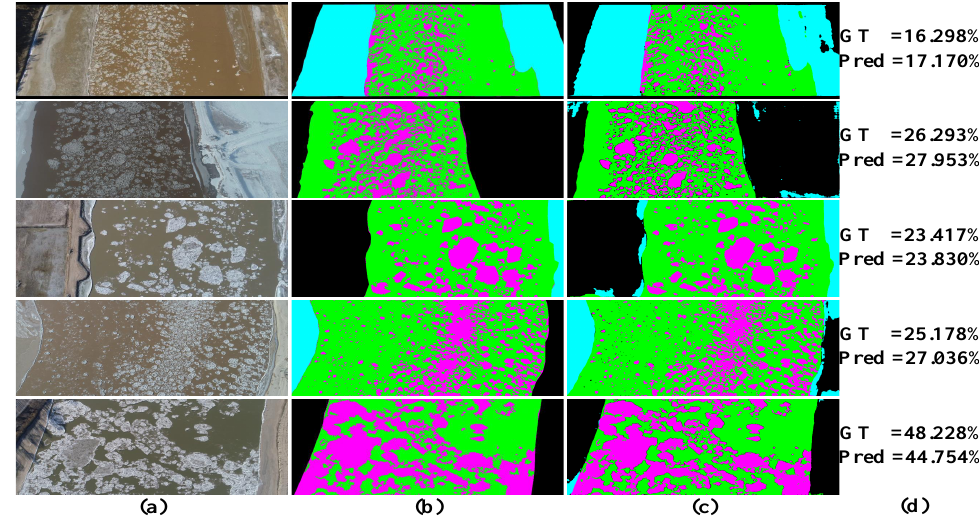
Figure 11. Experimental results of drift ice cover density. ( a – c ) respectively represent the images, the corresponding labels, and the prediction semantic segmentation maps. ( d ) shows the drift ice cover density calculated from the label and predicted semantic segmentation